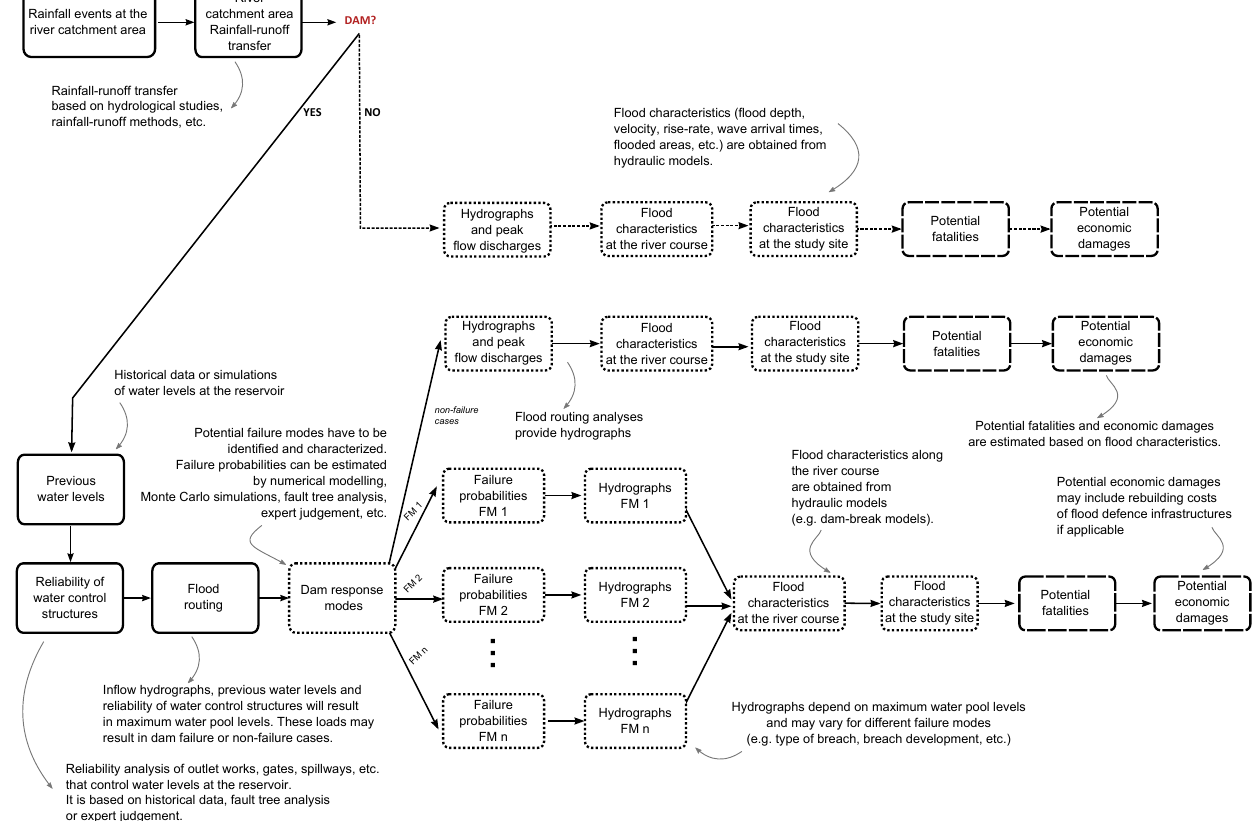
Fig. 3. Generic influence diagram: independent initiating event (Scheme A2). Note: nodes outlined with solid, dotted and dashed lines refer to loads, system response and consequences,